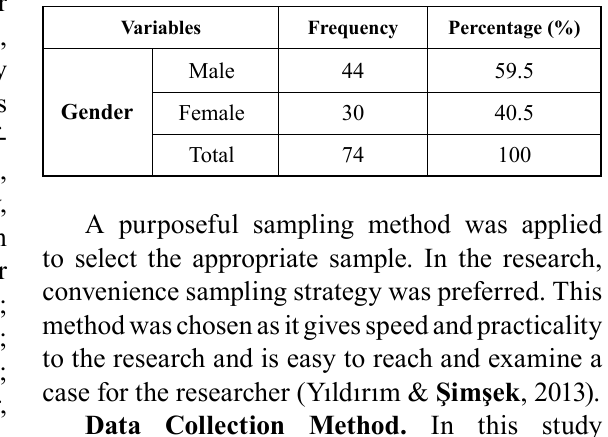
Table 1. Gender distribution of the research